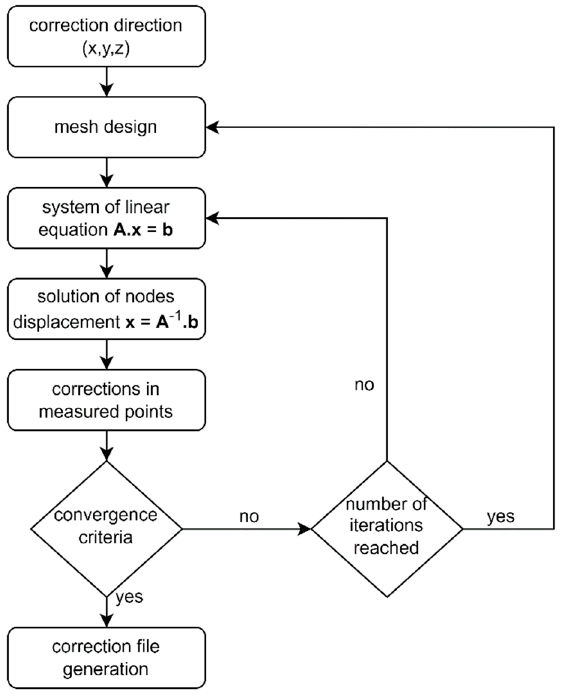
Figure 5. Flow chart of node translation calculations.